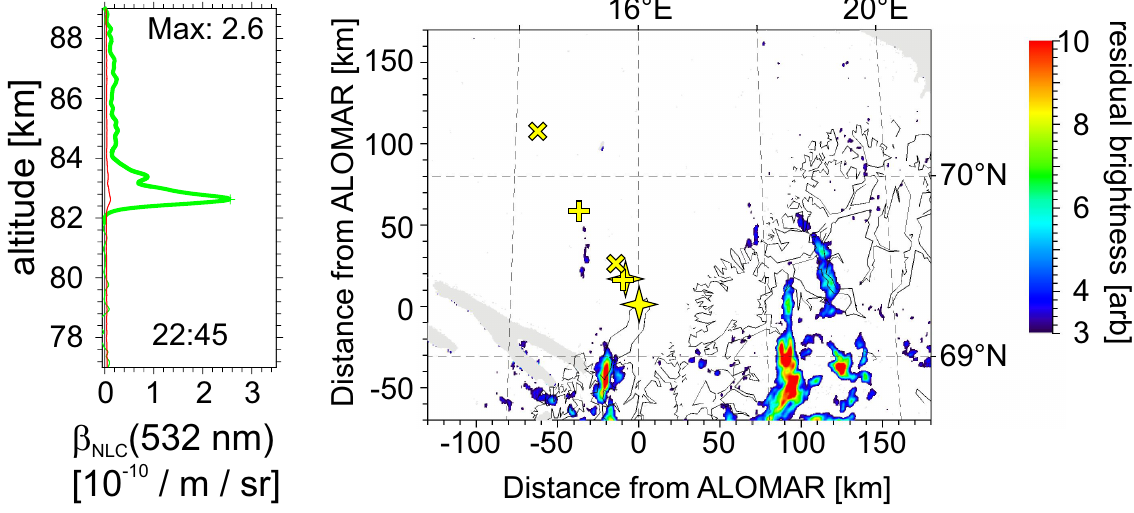
Fig. 11. Backscatter coefficient as measured by the ALOMAR RMR lidar on 3 August 2007 22:45UT with the North-West telescope (left) and simultaneous residual sky brightness (right) similar to Fig. 9. Areas in the image where tropospheric clouds north of Trondheim have disturbed the view towards ALOMAR were masked out and appear gray in the projected residual brightness. Stars in the map mark the lidar sounding volumes, pluses mark the ECOMA measurements on up and downleg and x-symbols mark the MASS